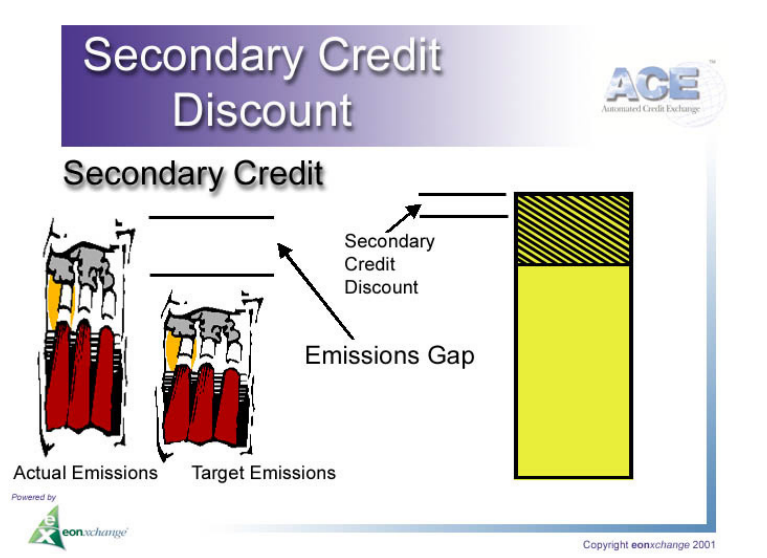
FIGURE 6. Secondary credit